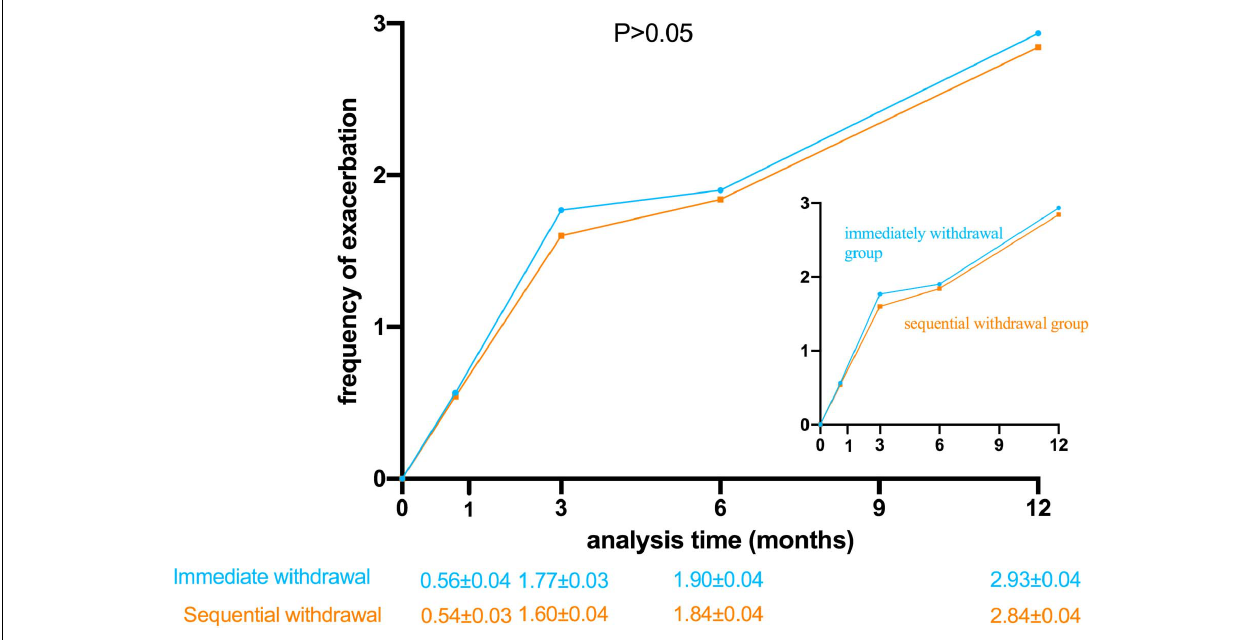
FIGURE 2 | Frequency of acute exacerbations in the immediate withdrawal group and the sequential withdrawal group with time following discharge. ( P >